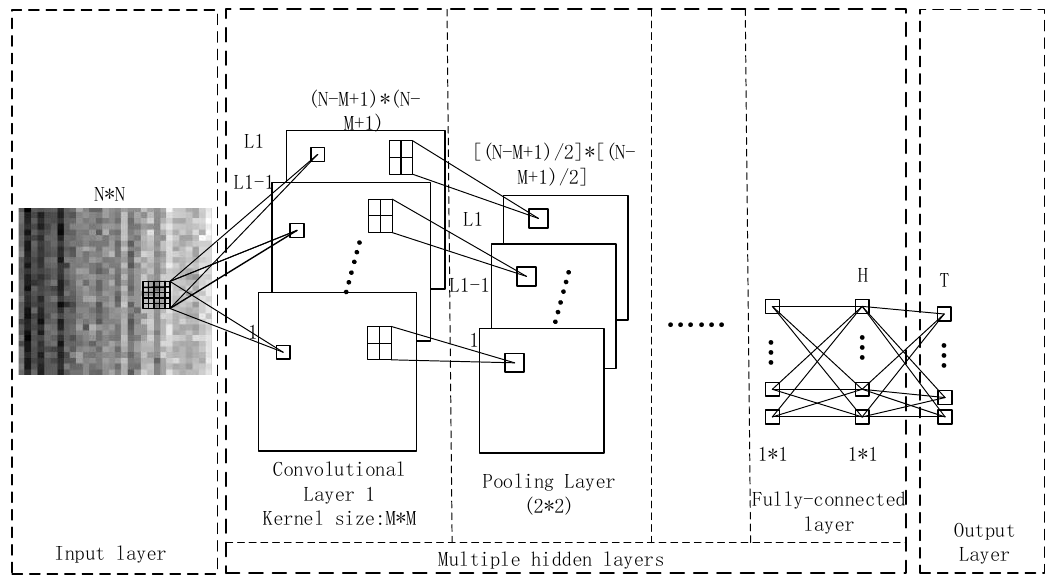
Figure 5. The general architecture of convolutional neural network (CNN) model for the process